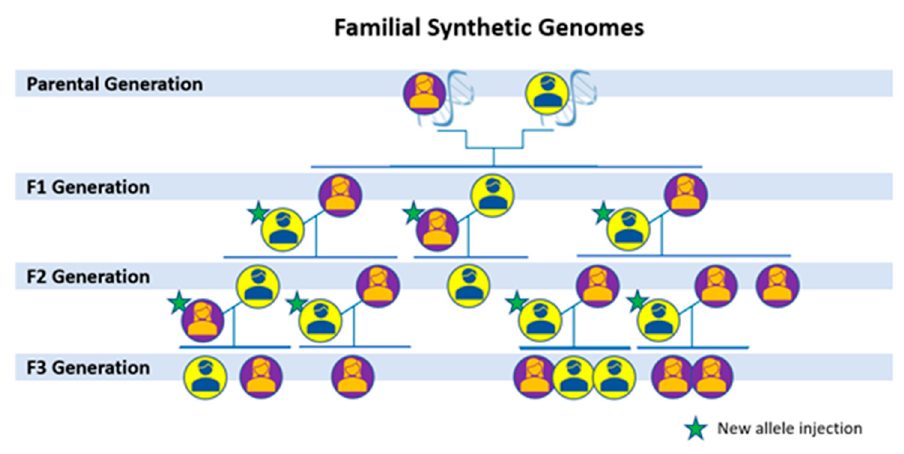
Figure A5. Generation of familial synthetic genomes.